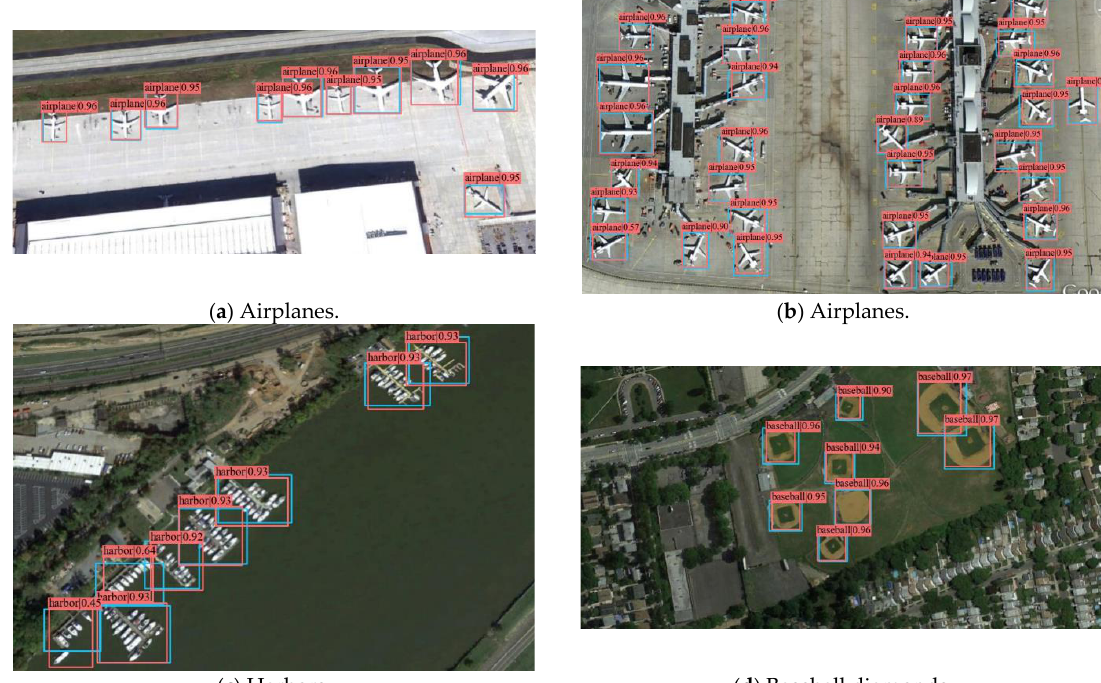
Figure 6. Qualitative inference results of T-TRD-DA on the NWPU VHR-10 data set.